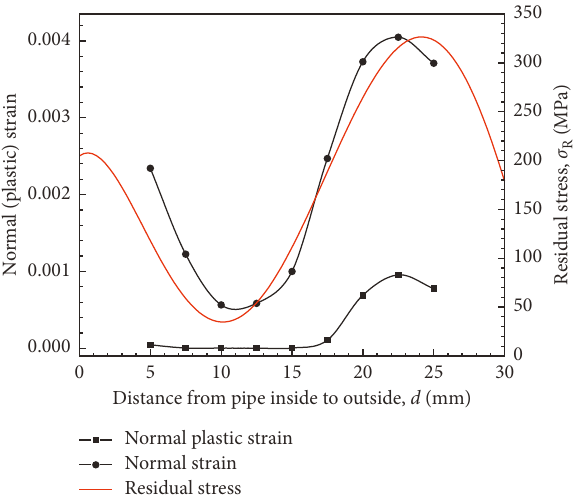
Figure 14: Strain at crack apex ( θ � 90 ° ) with crack